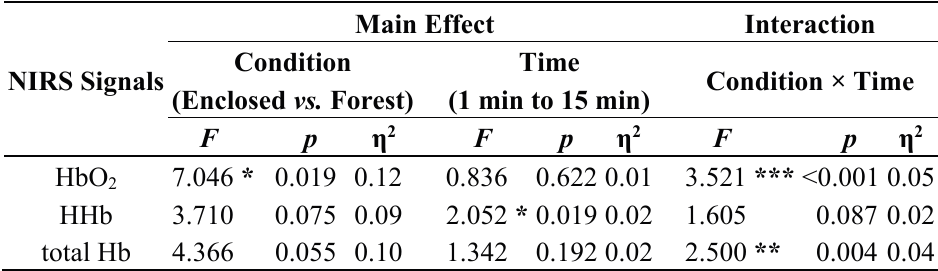
Table 2. Results of the two-way repeated measures ANOVA of NIRS signals. Main Effect NIRS Signals